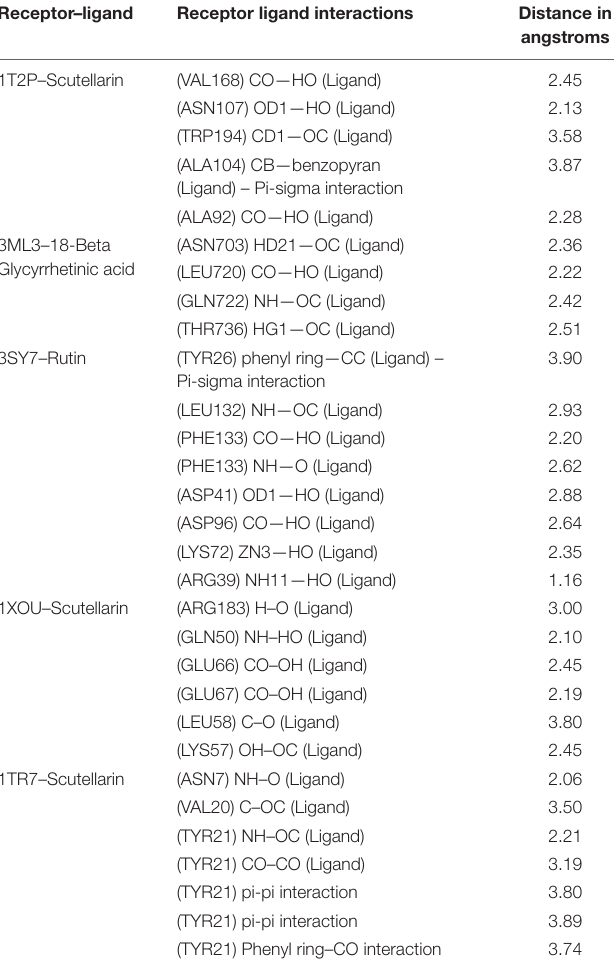
TABLE 6 | Interacting active site residues of receptors with different antibiofilm agents. Receptor–ligand Receptor ligand interactions Distance in